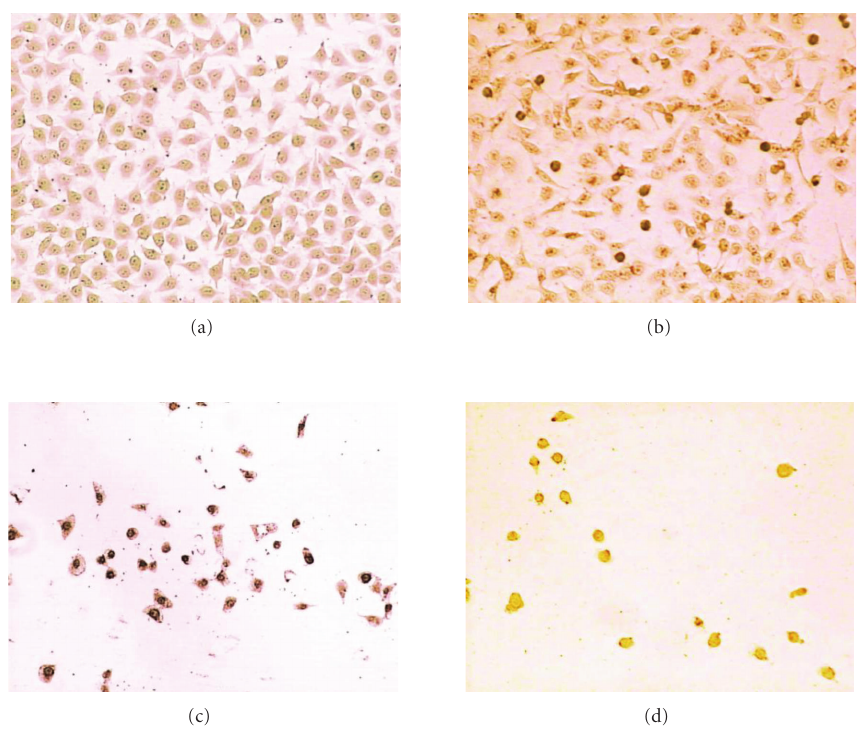
Figure 8: (a) P53 coloration before being induced; (b) bcl-2 coloration before being induced; (c) P53 coloration after being induced; (d) bcl-2 coloration after being